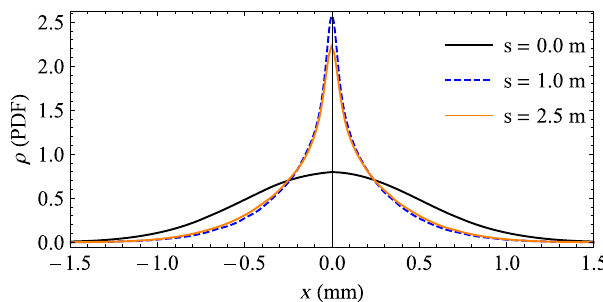
FIG. 10. Horizontal beam profiles at s ¼ 0 (initial) and at s ¼ 1 . 0 and 2.5 m. The beam is set on axis and vertical wakefields F